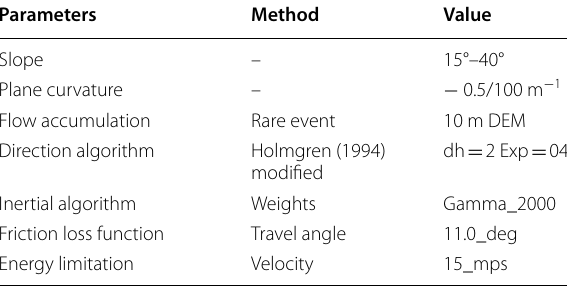
Table 2 Input parameters used in the Flow-R